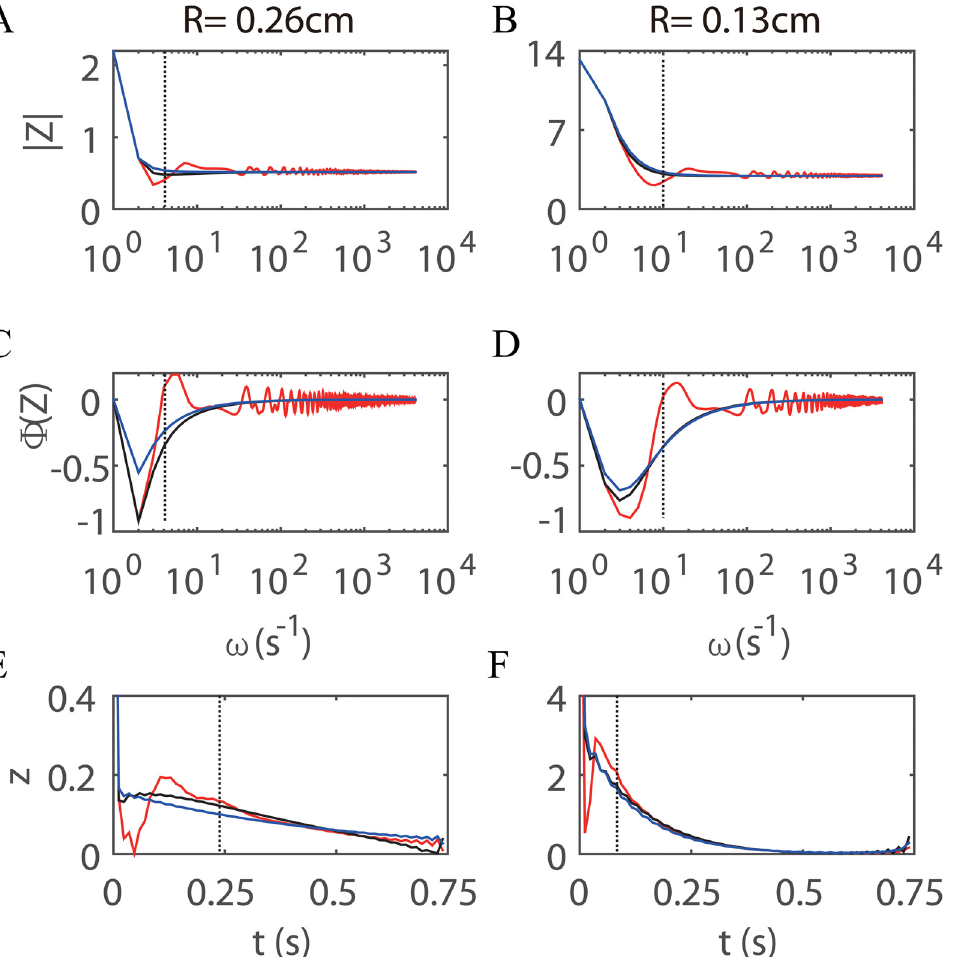
Fig 8. The impedance and kernel function obtained from the ST model and from the corresponding WK and CWK models. The line conventions are the same as those in Fig 4. The root-vessel radii are R = 0.26 cm and R = 0.13 cm for the left and the right panels, respectively, as marked on the top of the panels. The units of magnitude (A and B), phase (C and D) of the impedance, and the kernel function (E and F) are 10 4 gcm − 4 s − 1 , rad , and 10 5 gcm − 4 s − 1 , respectively. The vertical dotted line refers to the characteristic frequency in A-D and the corresponding characteristic time in E and